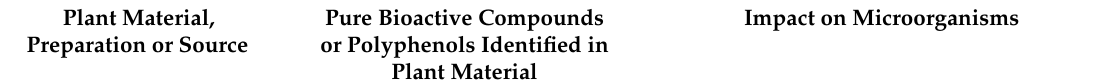
Table 1. Examples of the negative and positive impact of pure polyphenols or plant preparations (aqueous, ethanolic, methanolic or other extracts, essential oils, enriched extracts) on food-associated bacteria or the representatives of the human gastrointestinal tract microbiota.